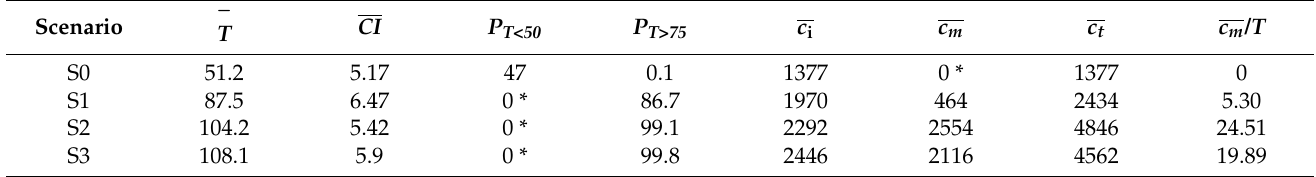
Table 7. Summary of statistical quantities for each